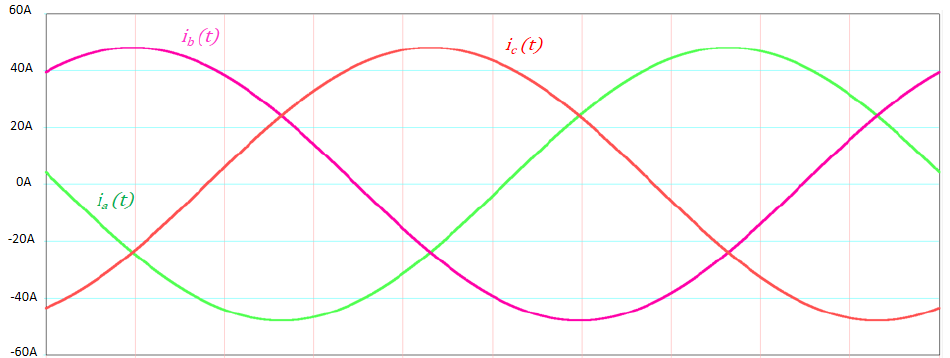
Figure 10. Line currents after compensation in PCC.